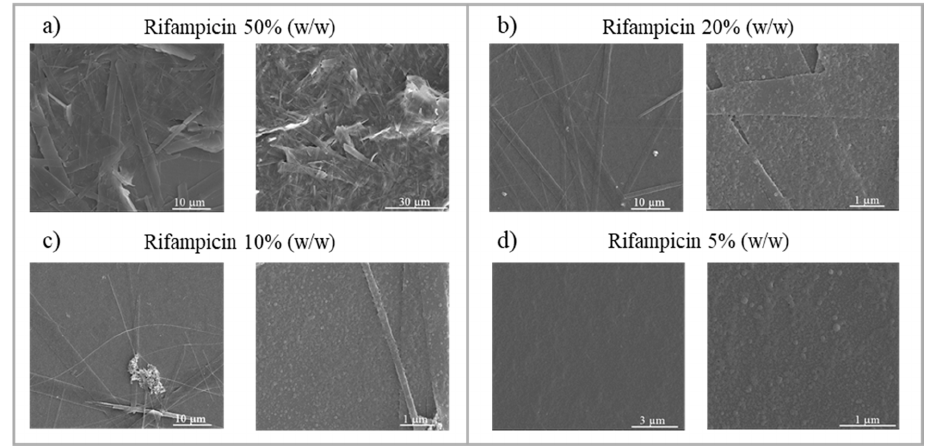
Figure 10. SEM visualization of rifampicin crystal formation at different rifampicin concentrations: ( a ) 50% (w/w), ( b ) 20% (w/w), ( c ) 10% (w/w), and ( d ) 5% (w/w) referred to polymer. The synthesis